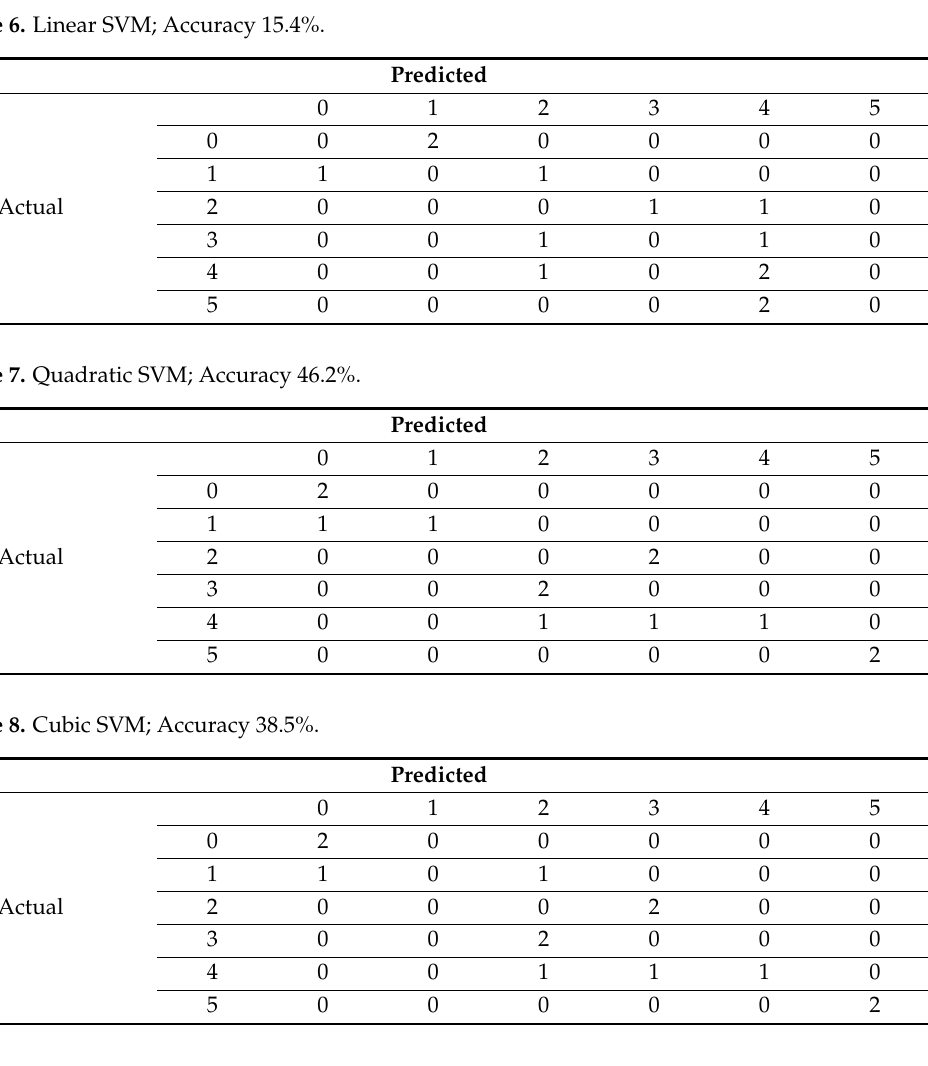
Table 9. Fine KNN; Accuracy 46.2%.